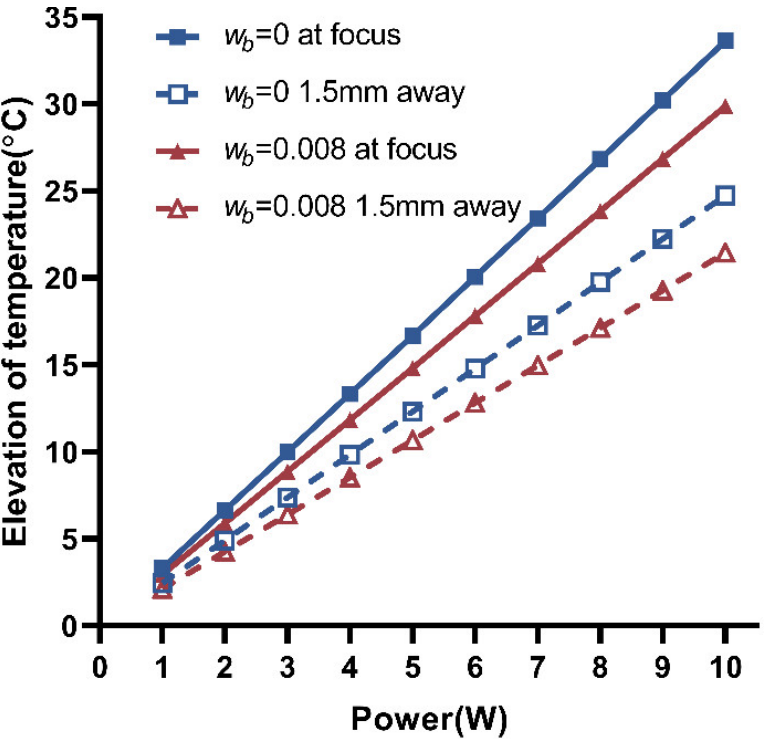
Figure 7. The temperature (predicted) of the bovine liver at 40 s at different power. The blue solid line presents the temperature at focus when ignoring blood perfusion ( w b = 0, at focus), the blue dotted line presents the temperature at 1.5 mm away from the focus when ignoring blood perfusion ( w b = 0, 1.5 mm away), the red solid line presents the temperature at focus when considering blood perfusion ( w b = 0.008, at focus), and the red dotted line presents the temperature at 1.5 mm away from the focus when considering blood perfusion ( w b = 0.008, 1.5 mm away). When the blood perfusion was ignored, for a 1 W increase in power, the temperature at focus increased by 3.3 ◦ C after sonication, and the temperature at 1.5 mm away from the focus increased by 2.5 ◦ C. When the blood perfusion was considered ( w b = 0.008), the temperature at focus increased by 3 ◦ C after sonication, and the temperature at 1.5 mm away from the focus increased by 2.1 ◦ C. With the increase in power, the temperature difference between the focus and at 1.5 mm from the focus gradually increased, and the effect of blood perfusion on the temperature gradually